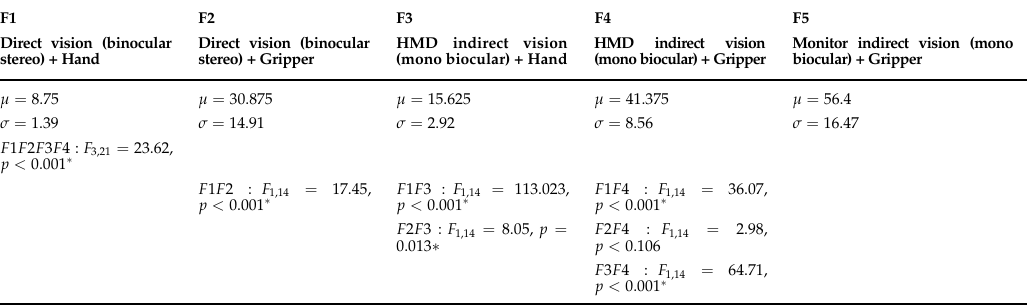
Table 4. Characterization of individual disturbance factors introduced by each mediation technology.